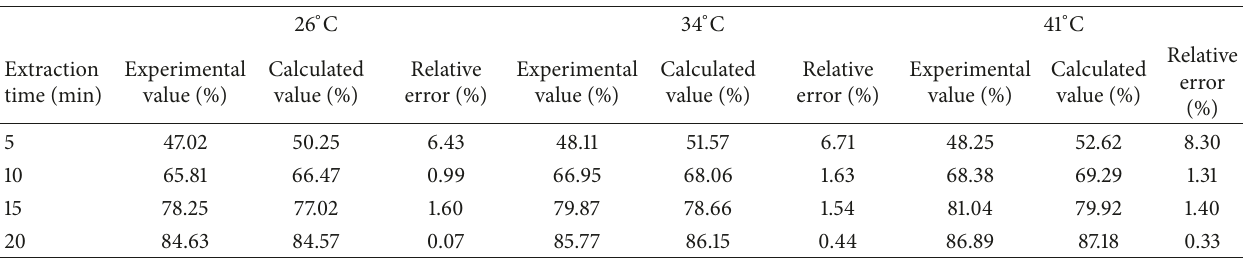
Table 2: The experimental and calculated